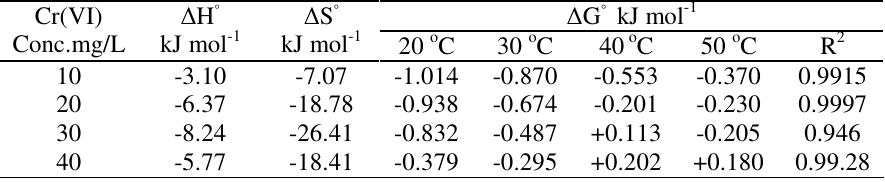
Table 2. Thermodynamic parameters for the adsorption of Cr(VI) onto